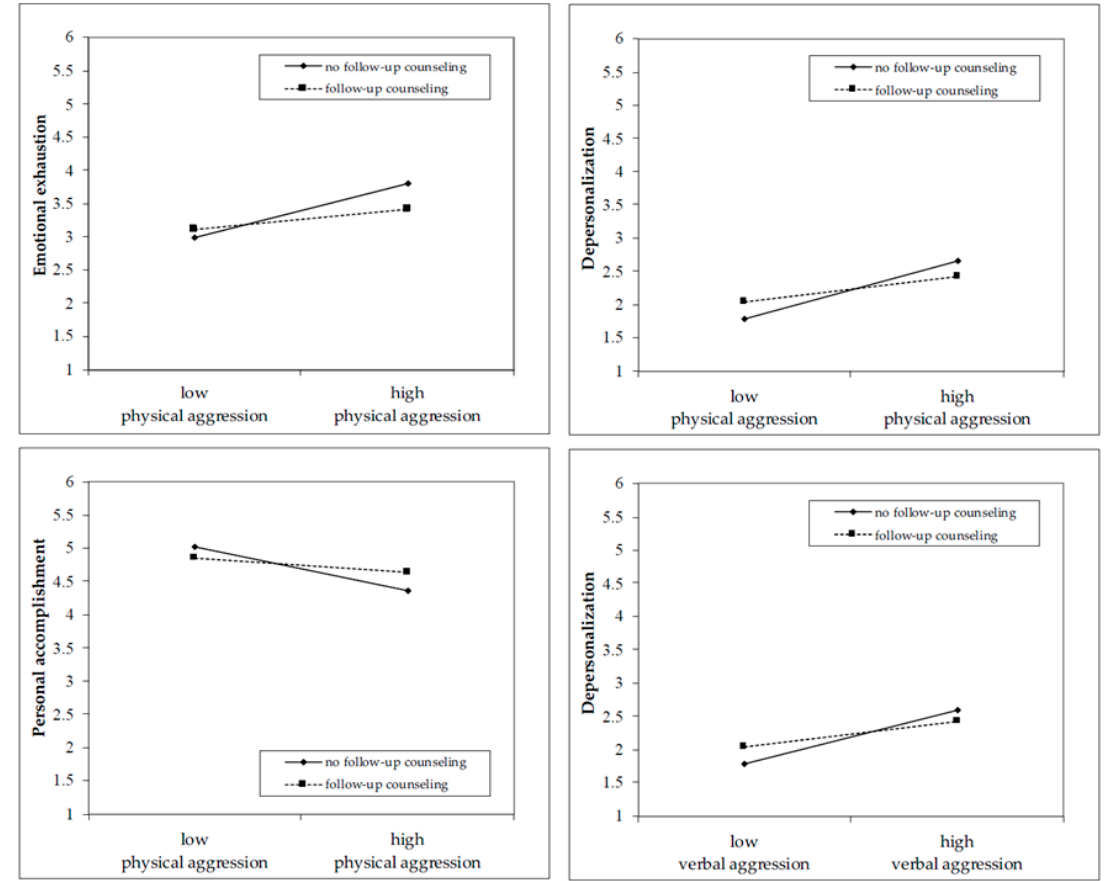
Figure 2. The moderating effects of follow-up counseling.